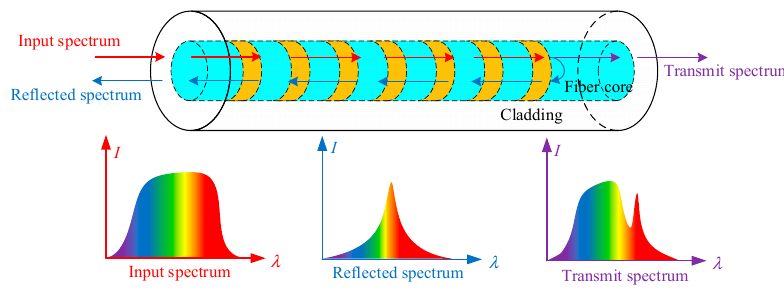
Figure 1. Schematic diagram of FBG sensing.